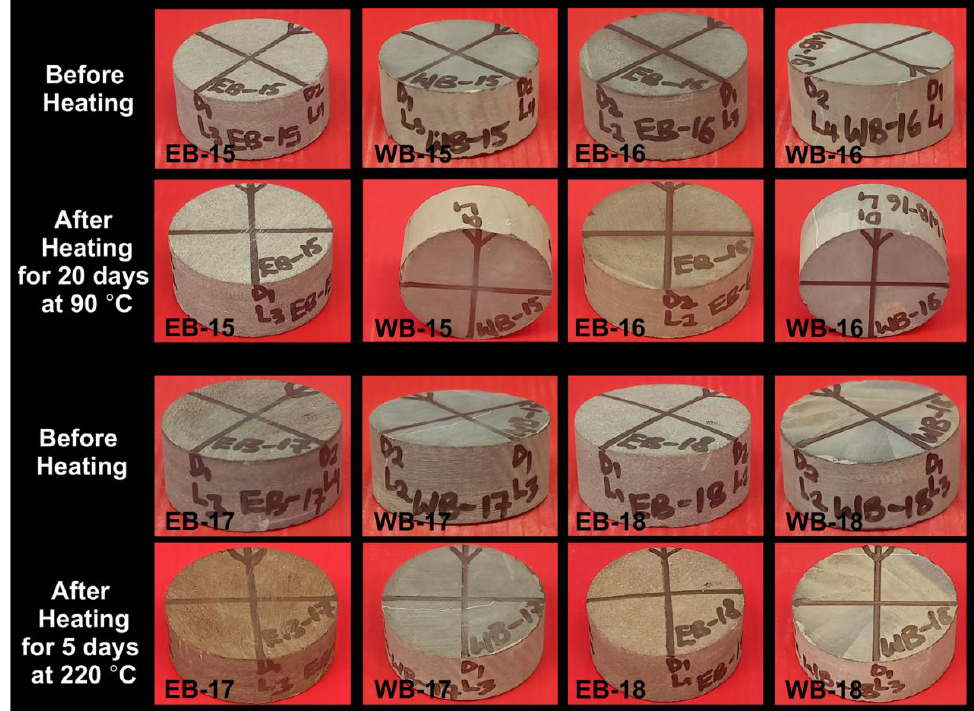
Figure 12. Pre- and Post-thermal conditioning of Eagle Ford and Wolfcamp shales for the periods of 20 days at 90 °C for EB-15, EB-16, WB-15, and WB-16 and 5 days at 220 °C for EB-17, EB-18, WB-17, and WB-18.